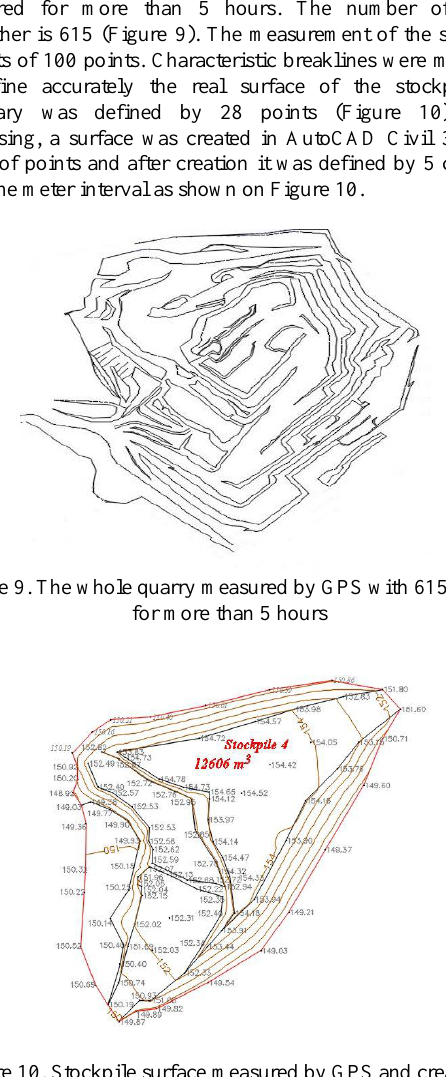
Figure 10. Stockpile surface measured by GPS and created